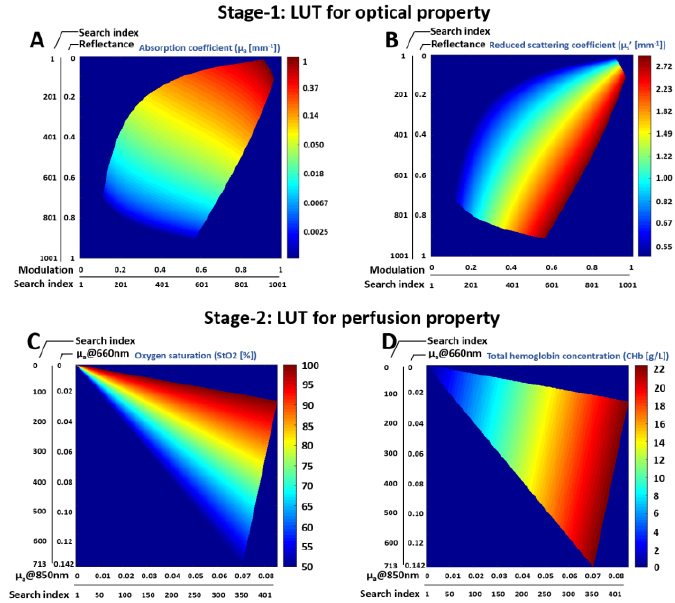
Figure 4. Two-stage LUTs for stage-1 optical ( A , B ) and stage-2 perfusion ( C , D ) property mapping. Reflectance and modulation in the stage-1 LUT, and absorption coefficients at 660 and 850 nm in the stage-2 LUT, were converted into search